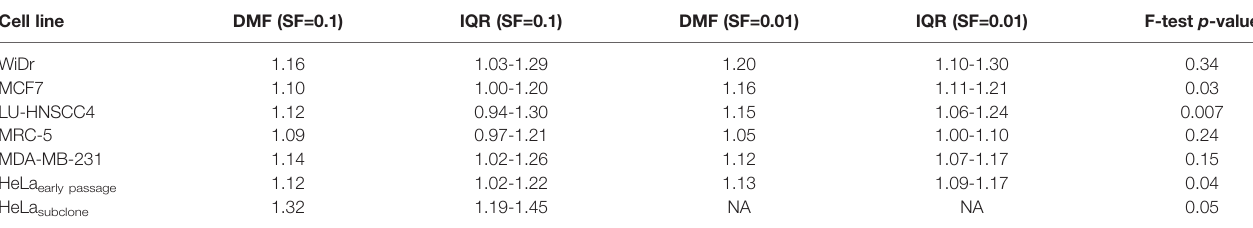
TABLE 1 | Dose modifying factors (DMF) at a surviving fraction (SF) of 0.1 and 0.01 for the various cell lines. Cell